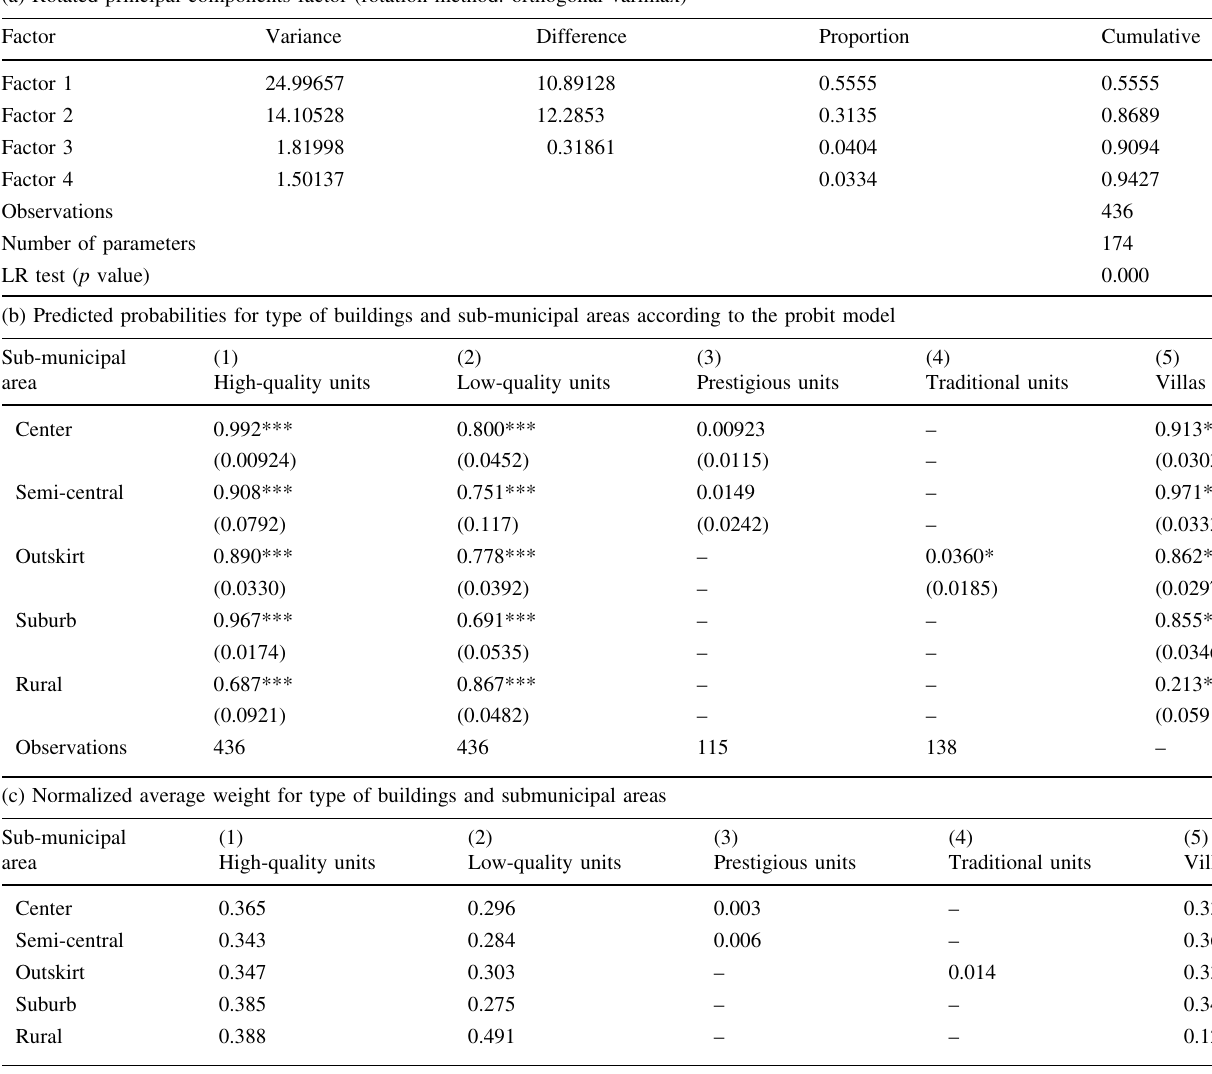
Table 4 Synthetic weighted average process (intermediate steps and final output) (a) Rotated principal components factor (rotation method: orthogonal varimax)